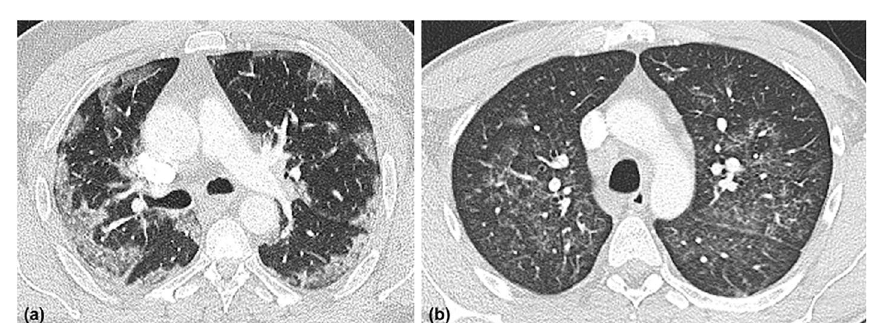
Figure 2. Bar charts. ( a ) Distribution of COVID-19 radiological RSNA scoring system according to vaccination status. P -value from Fisher’s Exact Test. P = 0.014. ( b ) Distribution of COVID-19 radiological CO-RADS scoring system according to vaccination status. P -value from Fisher’s Exact Test. P = 0.008. ( c ) Distribution of COVID- 19 radiological COV-RADS scoring system according to vaccination status. P -value from Fisher’s Exact Test. P = 0.001.